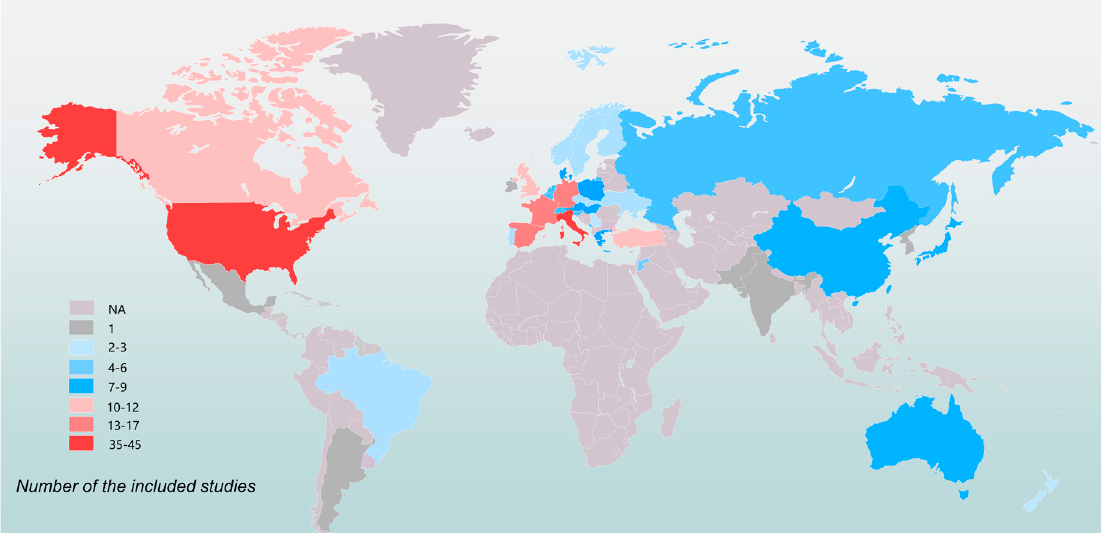
Figure 2. Geographical distribution of the 211 included studies. Table 1. Characteristics of the 206 studies included in this meta-analysis.